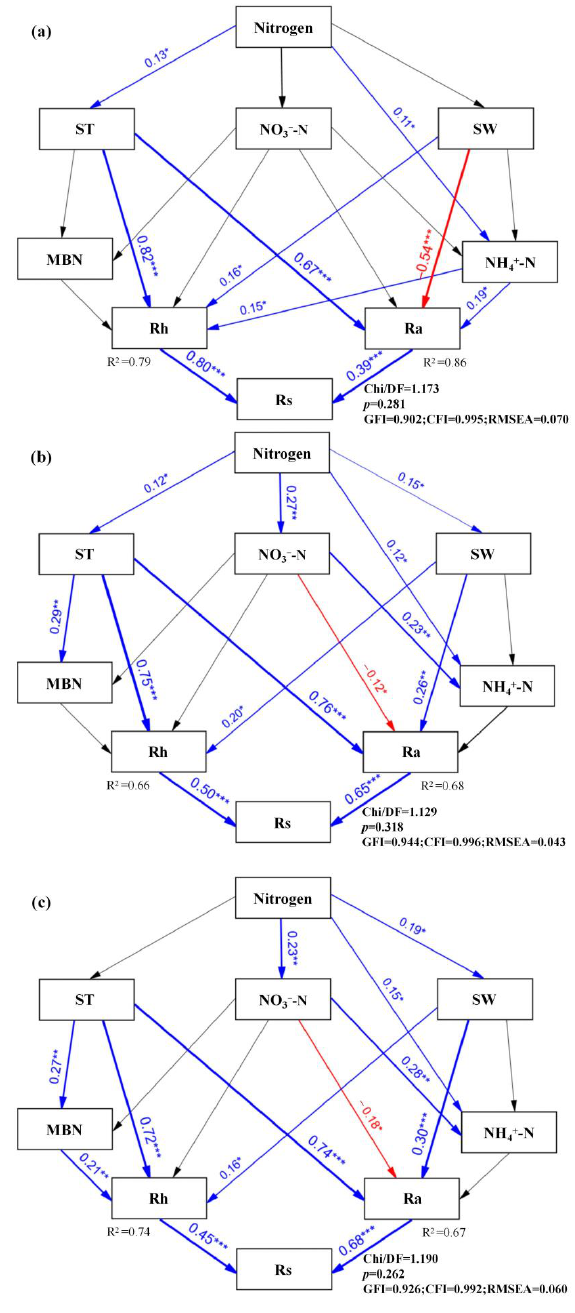
Figure 7. Results of the structural equation modeling performed to evaluate the direct and indirect effects of the factors influencing soil respiration and its components during the study period. Re- sponses of soil respiration and its components to soil factors in years 1 ( a ), 2 ( b ), and 3 ( c ). The blue and red arrows denote significant positive and negative correlations ( p < 0.05), respectively. The black lines indicate nonsignificant correlations ( p > 0.05). Numbers on the arrows represent standardized path coefficients, and the widths of the arrows are proportional to the strength of the path coefficients. ST, soil temperature; SW, soil moisture; NH 4 + -N, ammonium nitrogen; NO 3 − -N, nitrate nitrogen; MBN, microbial biomass nitrogen. *** p < 0.001, ** p < 0.01, * p <